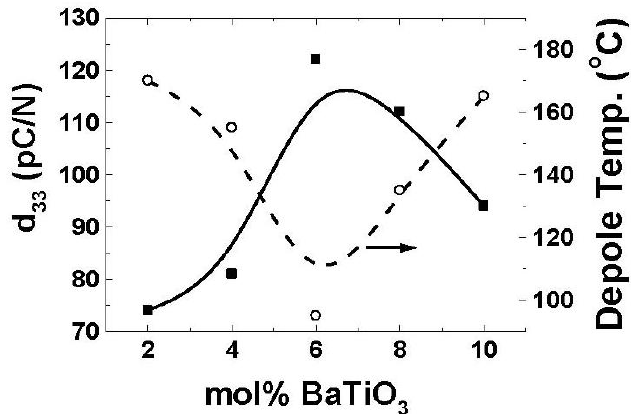
Figure 2. Variation of the piezoelectric constant and transition temperature (ferroelectric to antiferroelectric phase mentioned as depolarization temperature) as a function of BaTiO concentration in NBT–BT